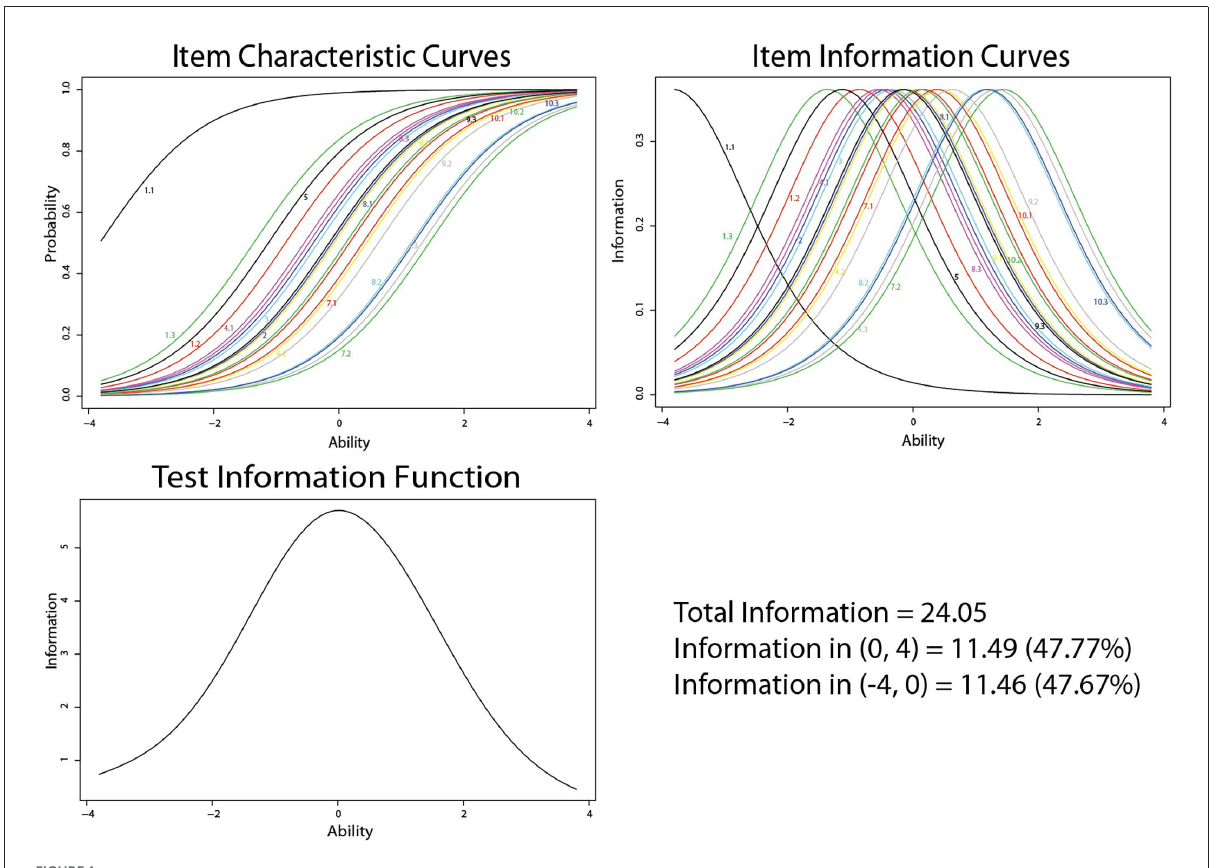
FIGURE1 Item characteristics of mathematical achievement